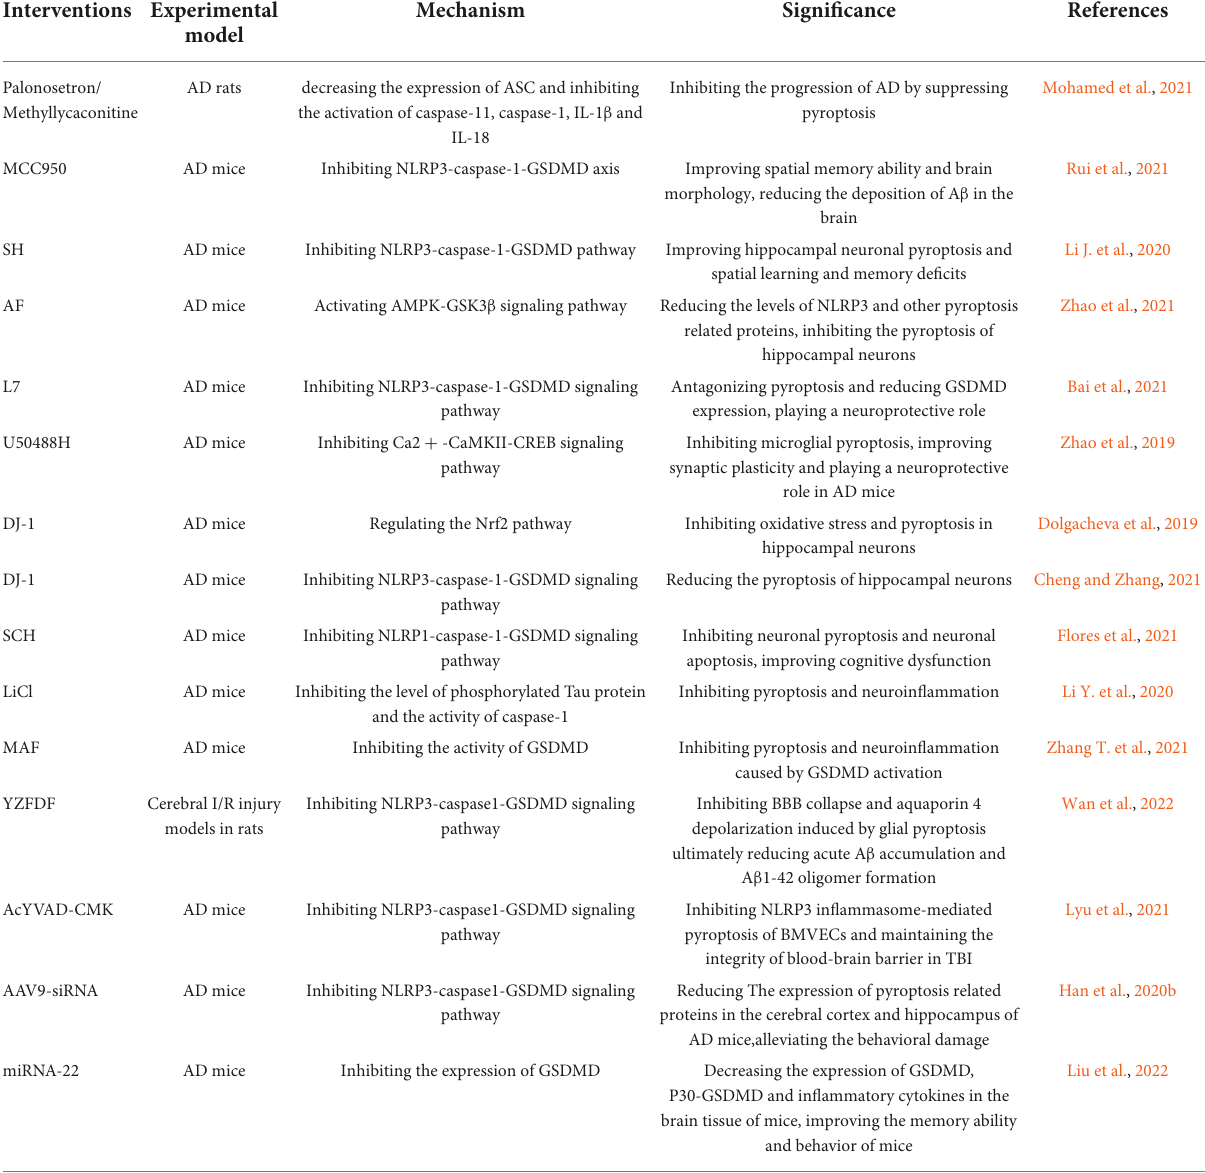
TABLE 2 Interventions targeting pyroptosis in AD treatment. Interventions Experimental